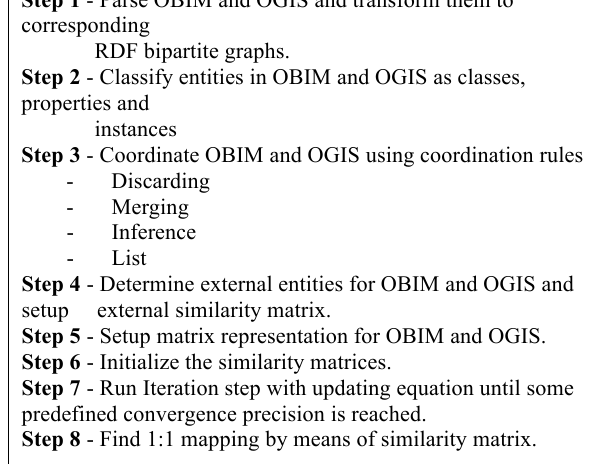
Figure 12. GMO Mapping algorithm for BIM-GIS Ontologies